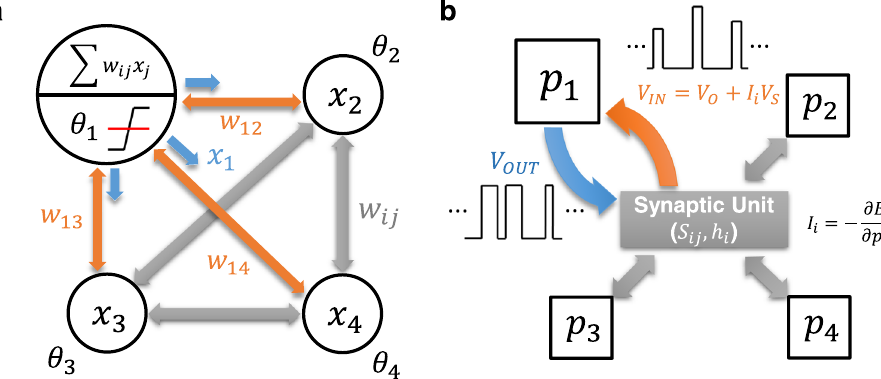
Fig. 1 | Architecture of the computing networks. a Network architecture of a stochastic Hop fi eld network. b Network architecture of a probabilistic